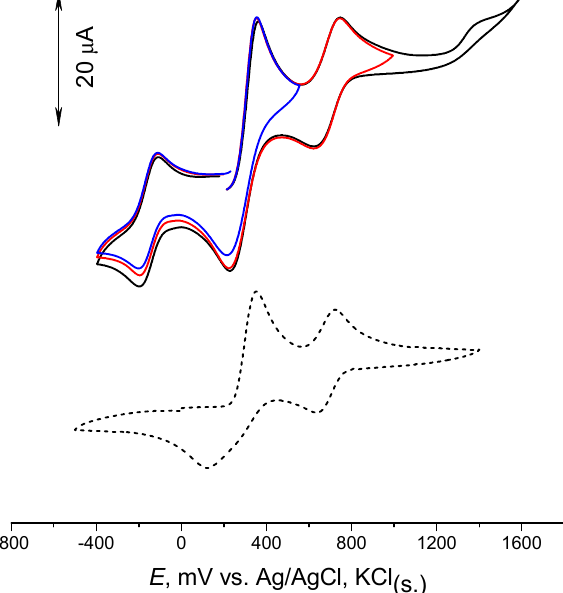
Figure 5. Voltammogram of I (solid lines, 2.1 mM at 0.05 M n -Bu 4 NBF 4 in MeCN, 50 mV / s, Pt) and Bu 4 NI (dashed line).